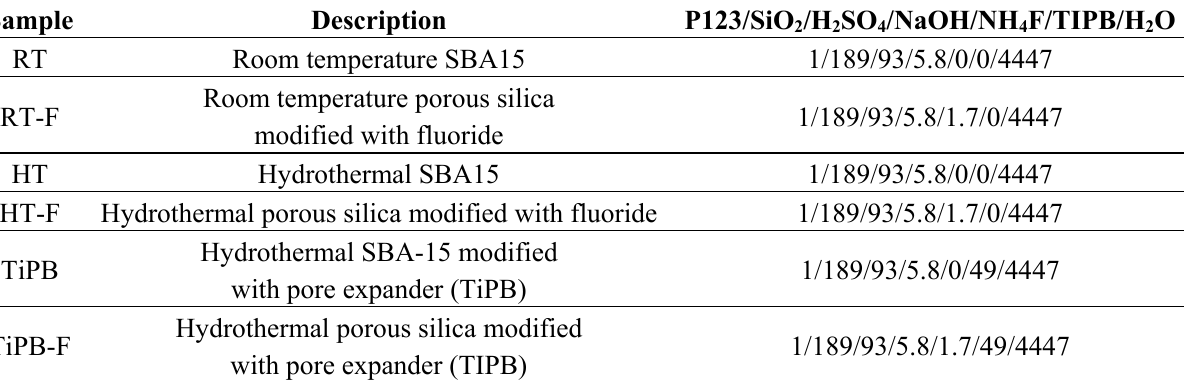
Table 1. Final molar compositon of the synthesis